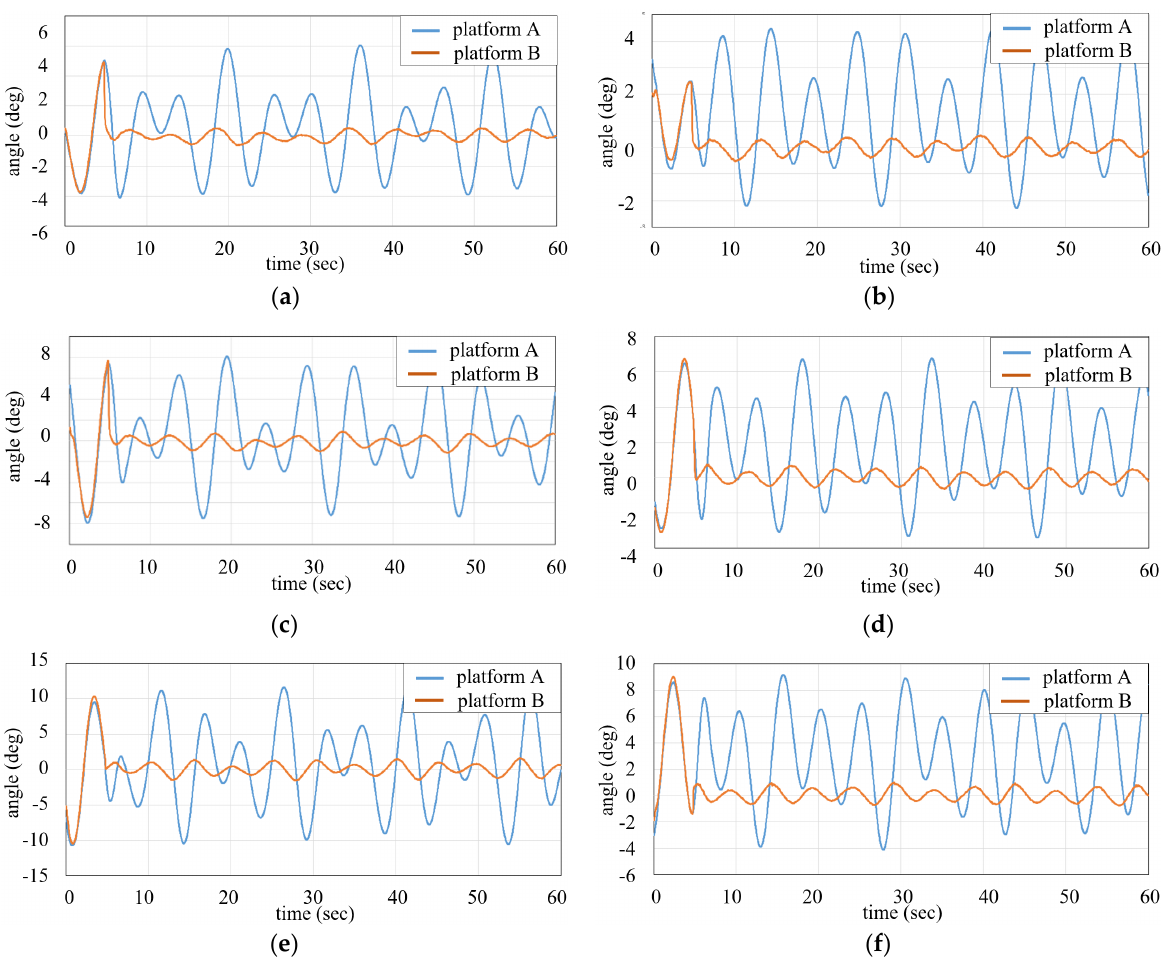
Figure 6. Self-Stabilized control in 3–5 level sea conditions. ( a ) Class 3 rolling; ( b ) Class 3 pitching; ( c ) Class 4 rolling; ( d ) Class 4 pitching; ( e ) Class 5 rolling; ( f ) Class 5 pitching.